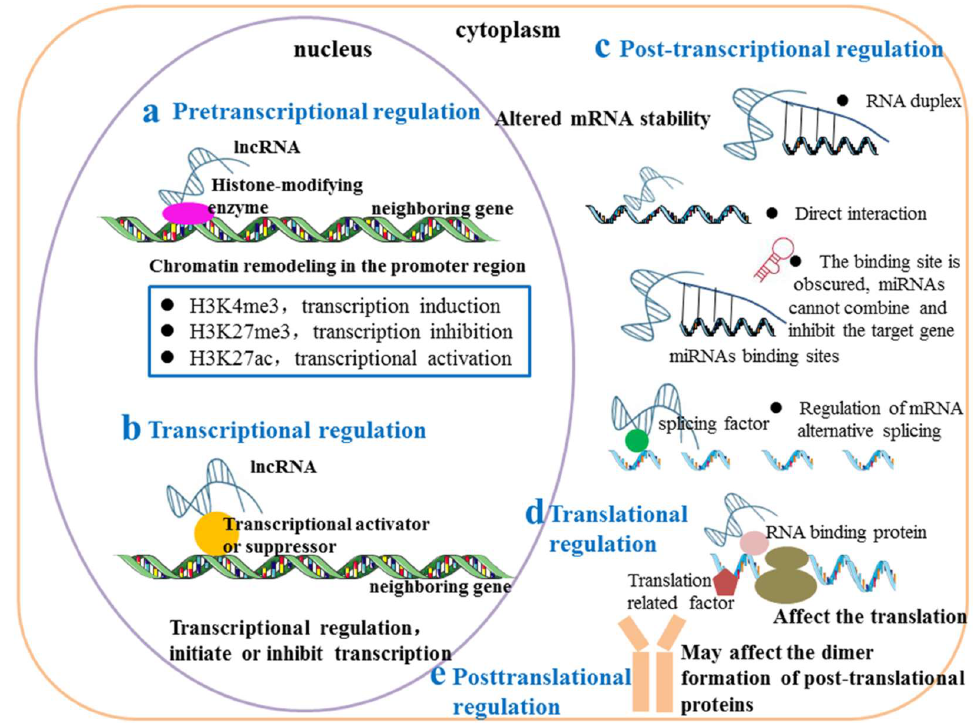
Figure 2. Regulation mechanisms of as-lncRNAs on neighbouring genes. ( a ) At the pretranscriptional level, as-lncRNAs reshape chromatin in the promoter region of neighbouring genes through histone modification enzymes, resulting in enrichment of H3K4me3/H3K27me3/H3K27ac in the promoter region, activating or inhibiting transcription of neighbouring genes. ( b ) At the transcriptional level, as-lncRNAs initiate or inhibit the transcription of neighbouring genes by interacting with transcription-related factors. ( c ) At the posttranscriptional level, as-lncRNAs regulate neighbouring gene expression by changing the stability of neighbouring gene mRNA or regulating the alternative splicing of neighbouring gene mRNA. as-lncRNAs can increase the stability of neighbouring gene mRNAs by forming RNA–RNA double strands with neighbouring gene mRNAs, change the mRNA stability of neighbouring genes by directly binding to the mRNA of neighbouring genes, or mask the binding site of miRNAs of neighbouring gene mRNAs to prevent the miRNAs from binding and inhibit the expression of neighbouring genes. ( d ) At the translation level, as-lncRNAs affect the translation of neighbouring genes by interacting with RNA binding proteins or translation-related factors. ( e ) At the posttranslational level, as-lncRNAs do not affect the expression of neighbouring genes but can affect the dimerization of neighbouring gene proteins, thereby affecting their activity.